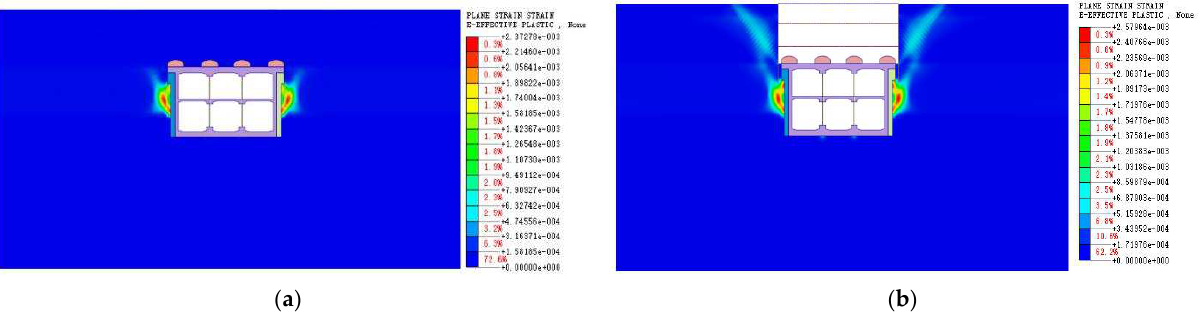
Figure 8. Comparison diagram of effective plastic strain before and after excavation: ( a ) before excavation; ( b ) after excavation.